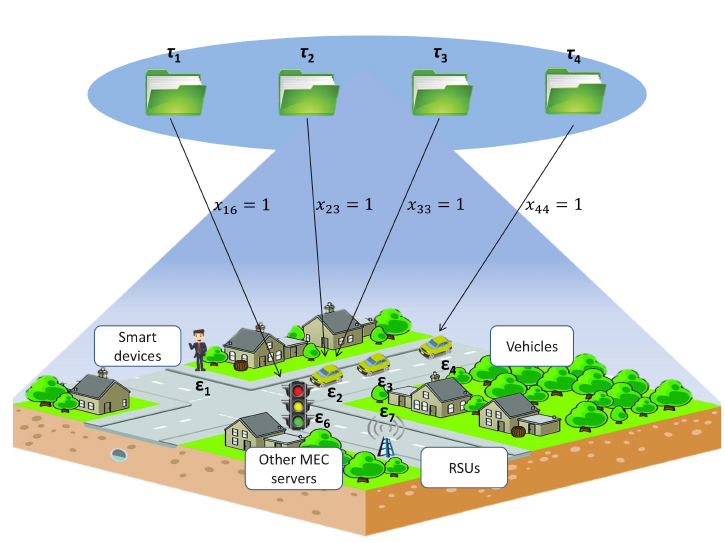
Figure 2. One-to-many